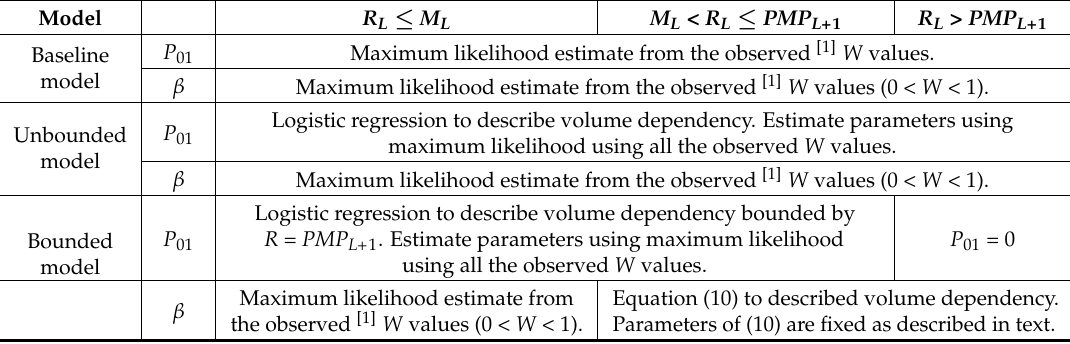
Table 1. Method of parameter estimation for different ranges of R for the unbounded baseline and bounded